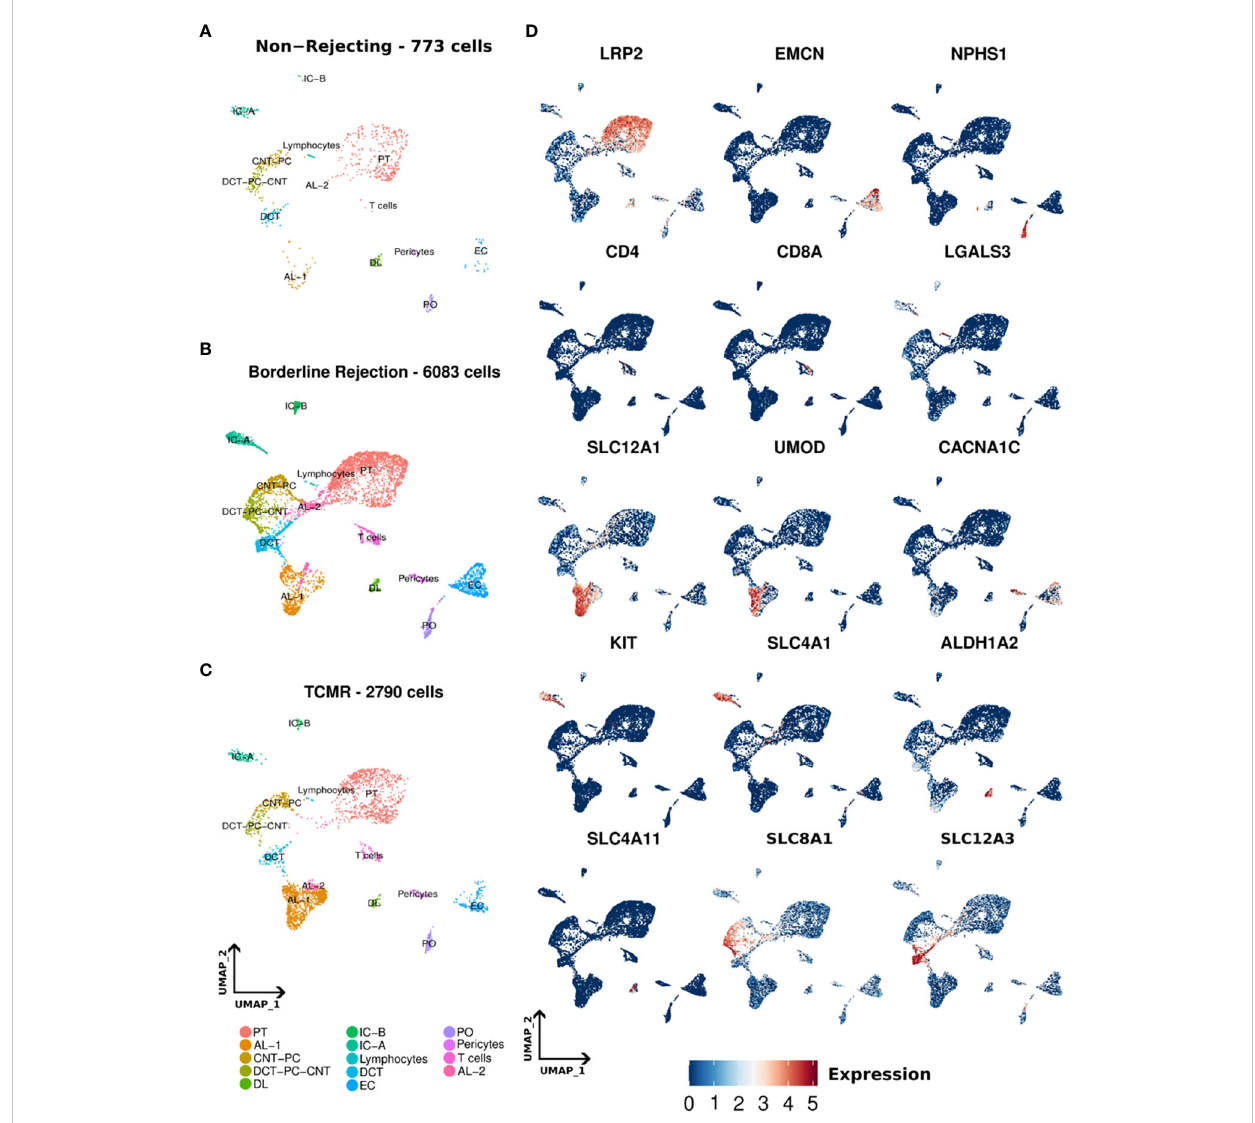
FIGURE 1 (A – C) Umaps of non-rejecting, borderline, and T-cell mediated rejection (TCMR) samples showing different clusters. (D) Umaps showing the expression of certain canonical markers used for cluster annotation. PT (Proximal tubules), AL-1 (Ascending loop of Henle-1), AL-2 (Ascending loop of Henle-2), CNT-PC (Connecting tubules-Principal cells), DCT-PC-CNT (Distal convoluted tubules-Principal cells- Connecting tubules), DL (Descending loop of Henle), IC-A (intercalated cells A), IC-B (intercalated cells-B), DCT (Distal convoluted tubules), EC (Endothelial cells), PO